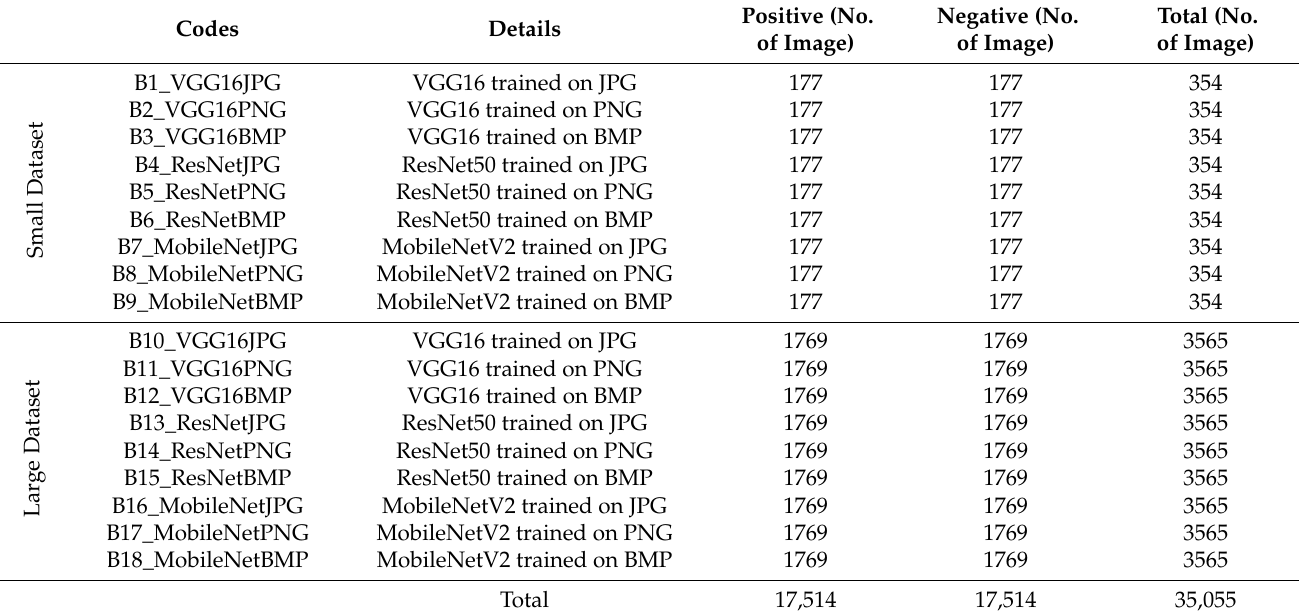
Table 1. Osteosarcoma nodules that have metastasized from bone to lung datasets for training. Codes Details